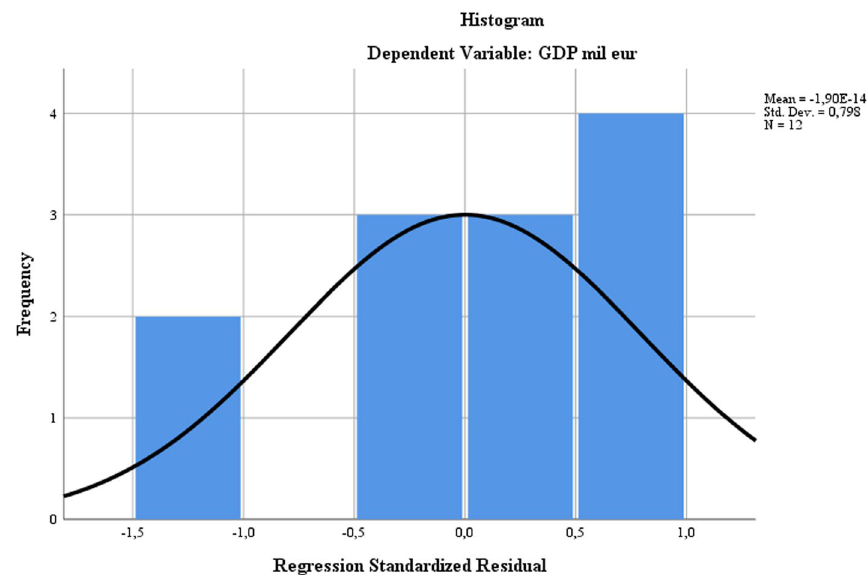
Fig. 5 Normal distribution of the dependent variable. Source : Author`s contributions